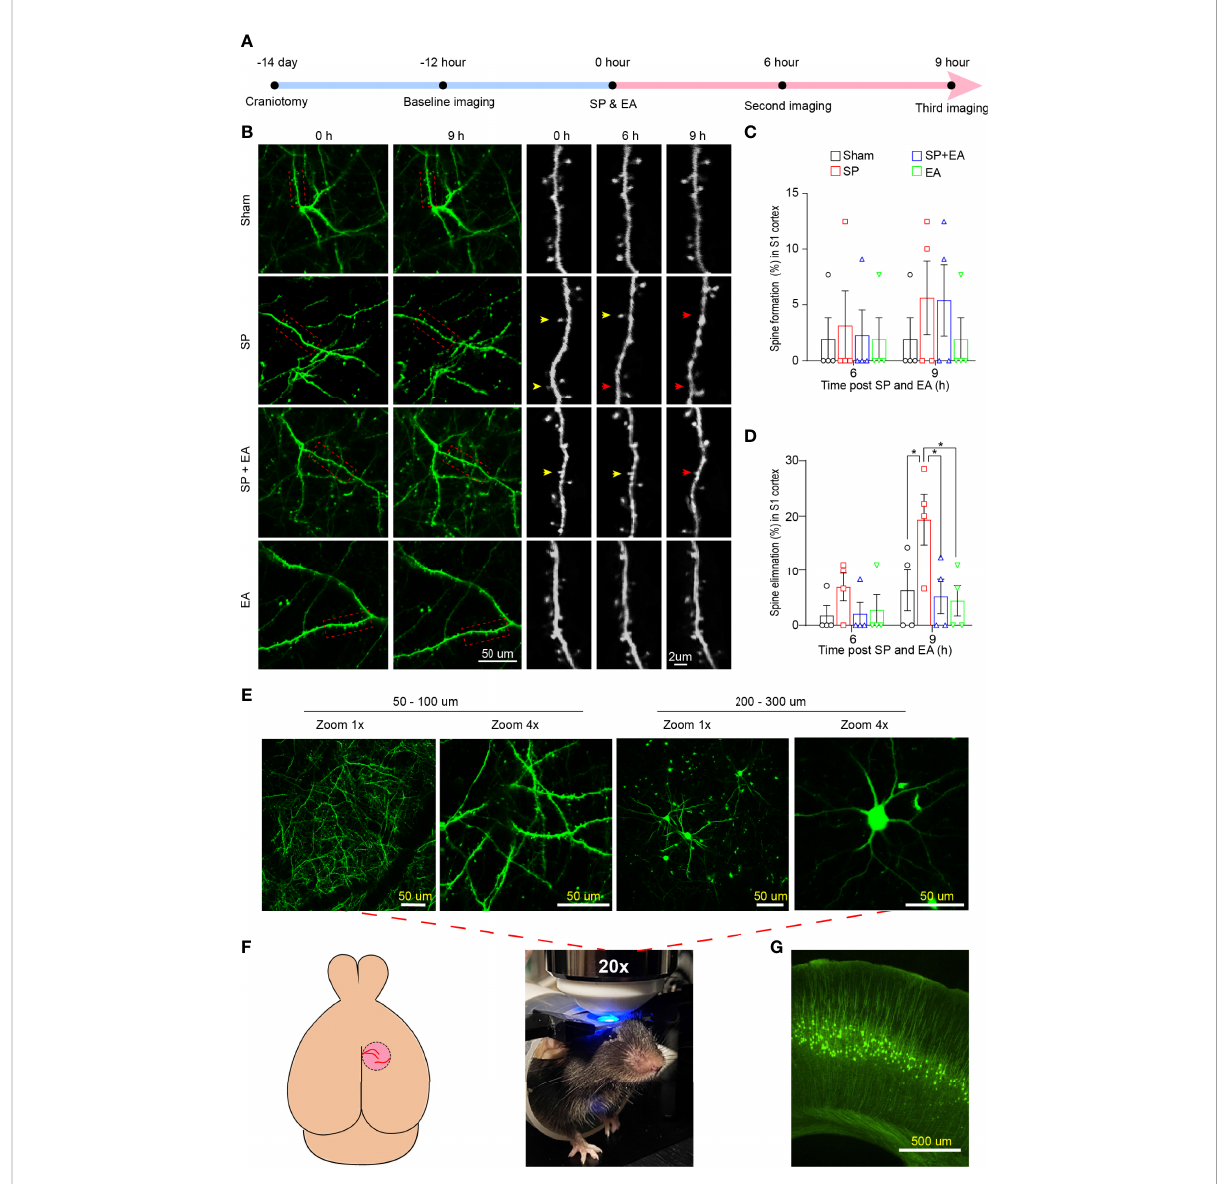
FIGURE 5 EA (DU20+KI1) attenuates the SP-induced changes in the formation and elimination of the cortical dendritic spine in mice 9 h after surgical incision. (A) Diagram of transcranial two-photon imaging work fl ow. (B) Left two panels, representative two-photon images of same pyramidal dendrites acquired at baseline and 9 h after surgical incision individually. Right three panels, repeated imaging of the boxed dendritic segment after surgical incision and EA stimulation with a higher-magni fi cation view of the boxed dendritic segment at baseline, 6 h, and 9 h after the surgical incision. Arrowheads indicate dendritic spines dynamics at the indicated time points. Yellow arrowheads represent spines that remained in situ ; red arrowheads represent spine elimination. (C) SP did not cause signi fi cant differences in the dendritic spines formation rate in the somatosensory cortex of mice compared to sham condition at 6 or 9 h after the procedure ( n = 4, two-way ANOVA followed by Bonferroni post-hoc analyses). (D) SP signi fi cantly increased the dendritic spines elimination rate in the somatosensory cortex of mice compared to sham condition at 6 or 9 h after the procedure ( n = 4, two-way ANOVA followed by Bonferroni post-hoc analyses). p -values indicate the difference in spine elimination rate between SP vs. sham, SP vs. SP plus EA, and SP vs. EA ( n = 4, two-way ANOVA followed by Bonferroni post-hoc analyses. (E) Lower panel, mouse head restrained for transcranial two-photon imaging; upper panel, representative images of cortical dendrites and pyramidal neurons at different depths of the S1HL cortex in YFP mouse. Scale bars represent 50 µm. (F) Schematic of the mouse brain and transcranial window for two-photon imaging. (G) Representative YFP mouse brain slice taken at 4×. Scale bar represents 500 µm. All images were scanned with a green fi lter. Data are represented as mean ± SEM. * p < 0.05. SP, surgical pain; EA, electroacupuncture; SEM, standard error of